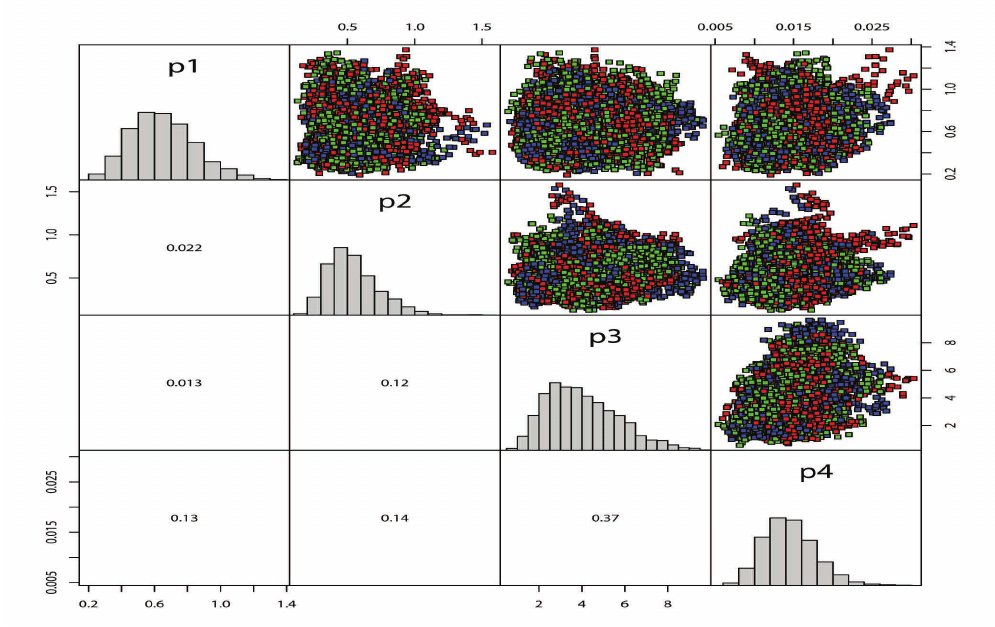
Figure 8. Pairs plots of the MCMC samples for parameter estimates of stress–strength for EED based on complete sample.